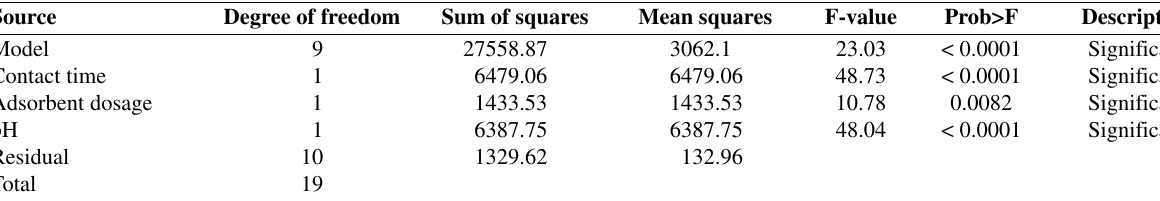
Table 7. Regression analysis (ANOVA) for the removal of MB from dye solution